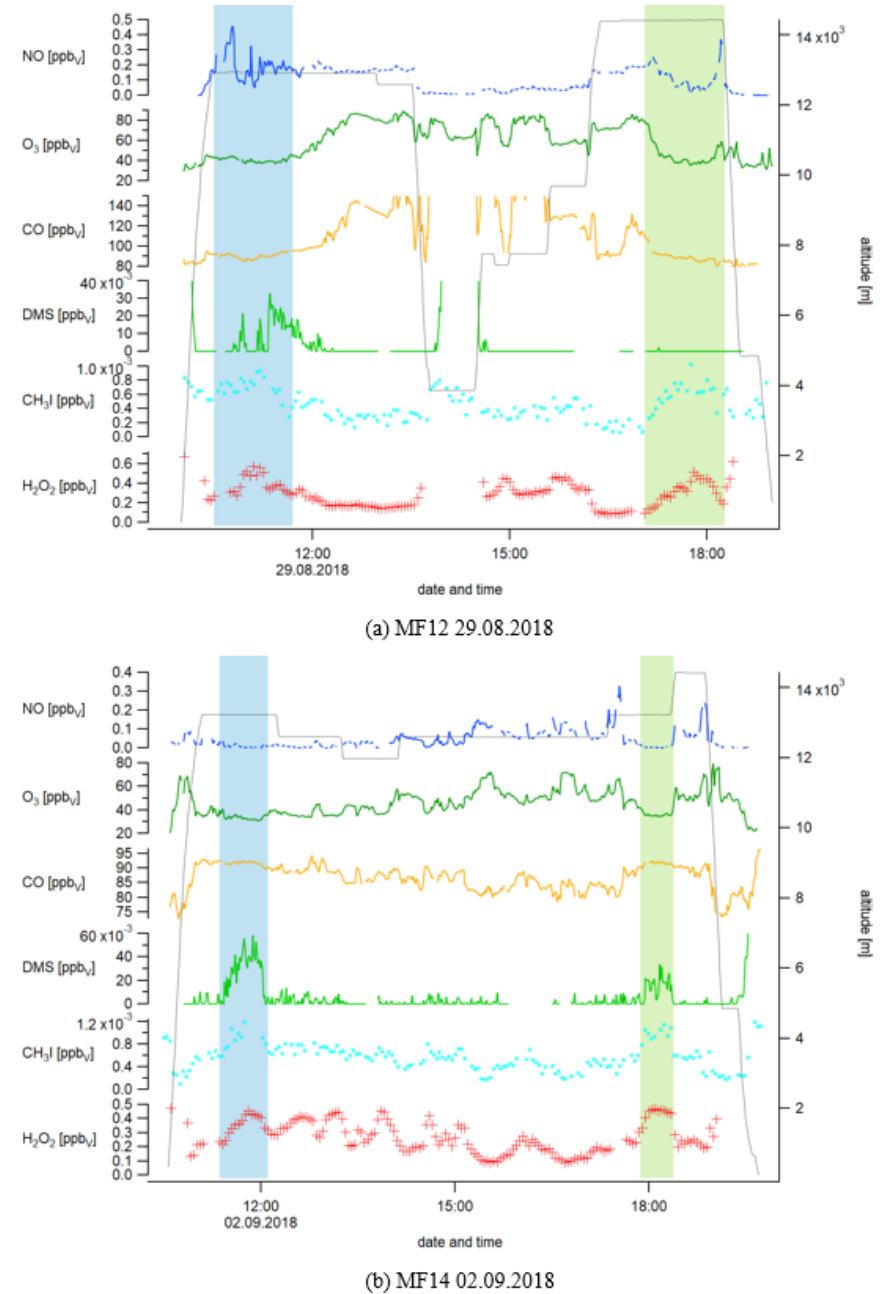
Figure 3. Overview of the temporal development of the observed trace gases NO, O 3 , CO, DMS, CH 3 I and H 2 O 2 during measurement flights MF12 and MF14. Blue and green bars show the time intervals for which the research aircraft had passed high cloud tops (compare Fig. 1c and d). The overview for MF10 can be found in Fig. S1 of the